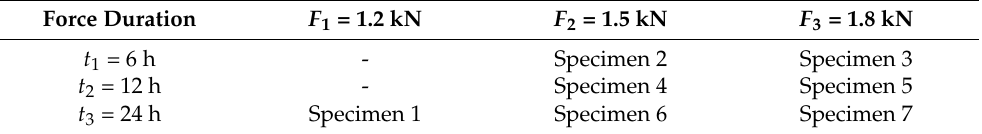
Table 2. Description of time and static force used for initiation of corrosion cracks. Force Duration